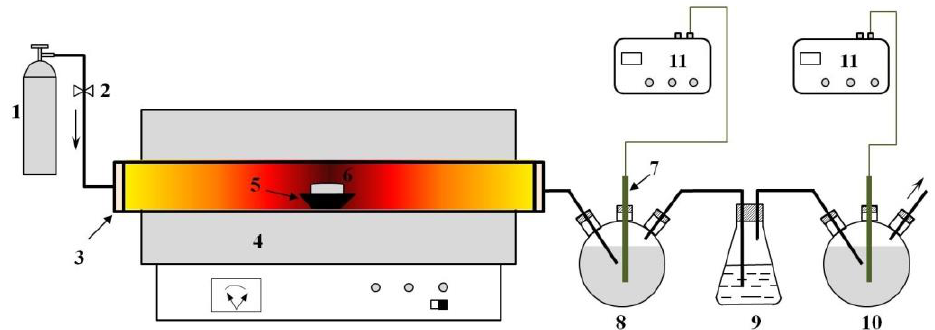
Figure 1. Component diagram of experimental equipment for roasting. 1—N 2 gas cylinder; 2—Flow meter; 3—Sealing flange; 4—Tube furnace; 5—Crucible; 6—Sample; 7—Electrode; 8—KMnO 4 solution; 9—Azaleine solution; 10—Na 2 CO 3 solution; and 11—pH meters.